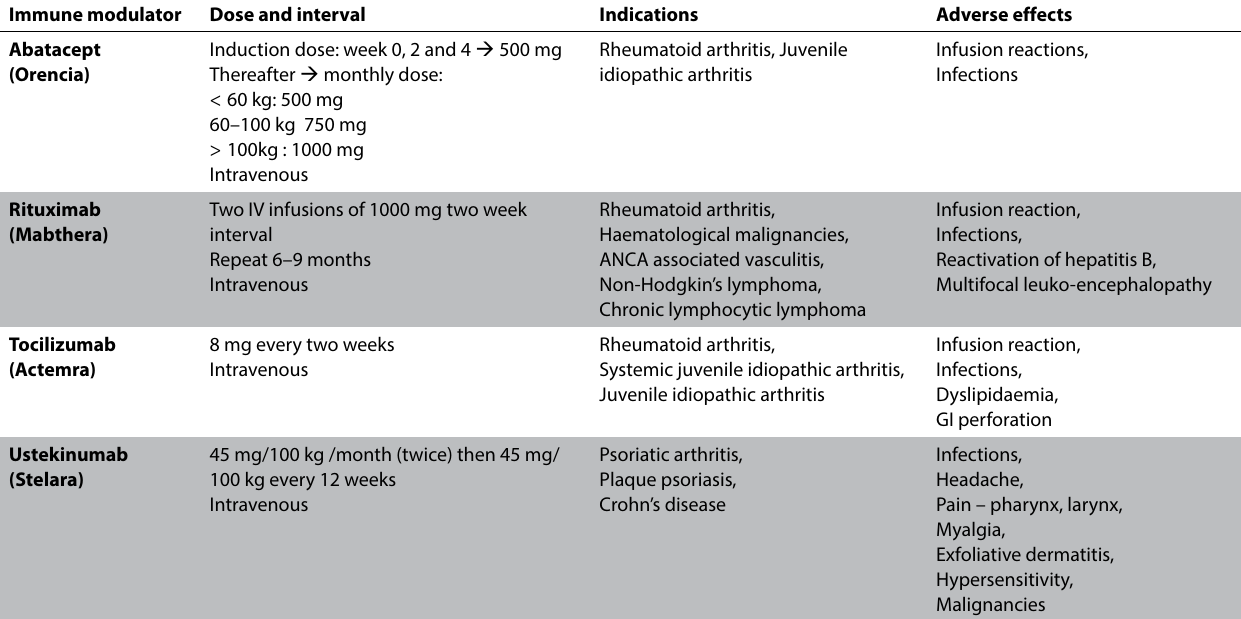
Table 2. Summary of the non-TNF-α biological DMARDs, their dosage, primary indications and common and serious adverse effects Immune